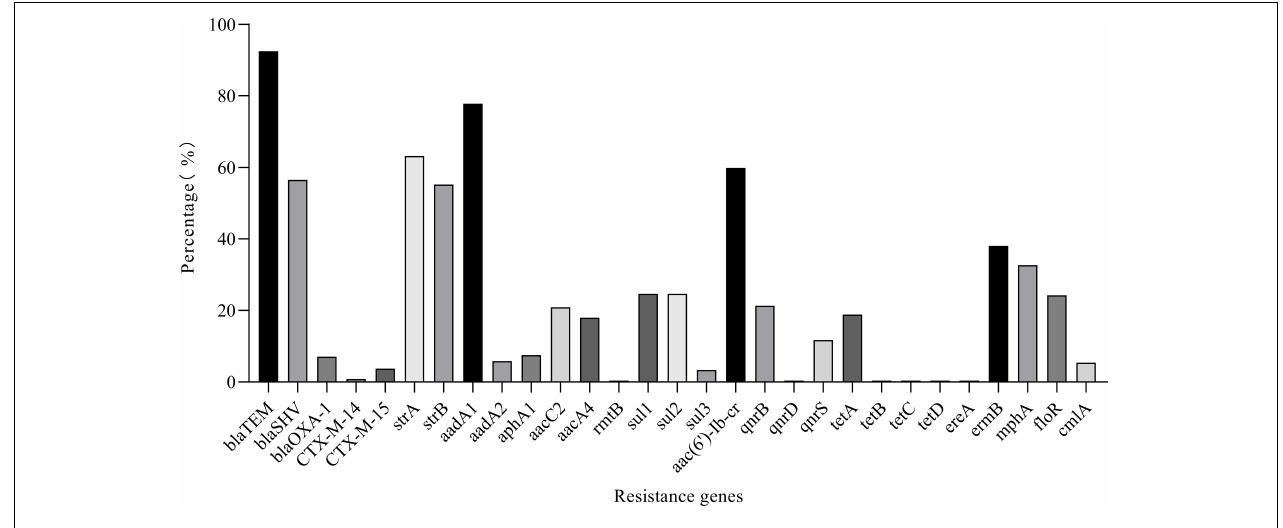
FIGURE 7 | Detection rate of resistance